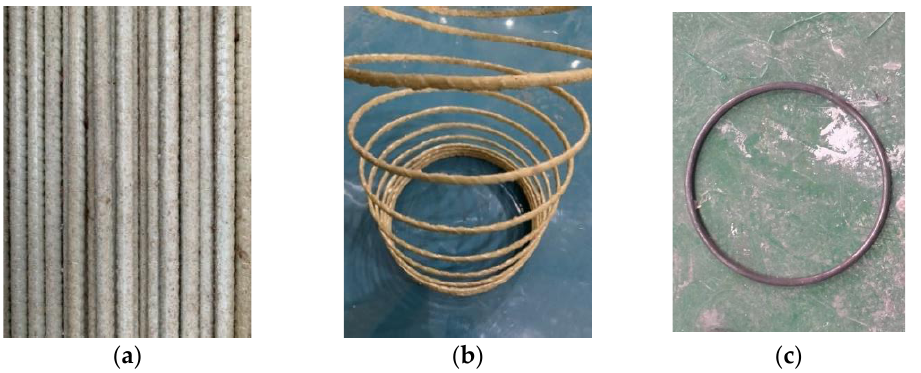
Figure 2. Longitudinal bars and stirrups. ( a ) GFRP longitudinal bars; ( b ) GFRP spiral stirrups; ( c ) Round steel stirrups.